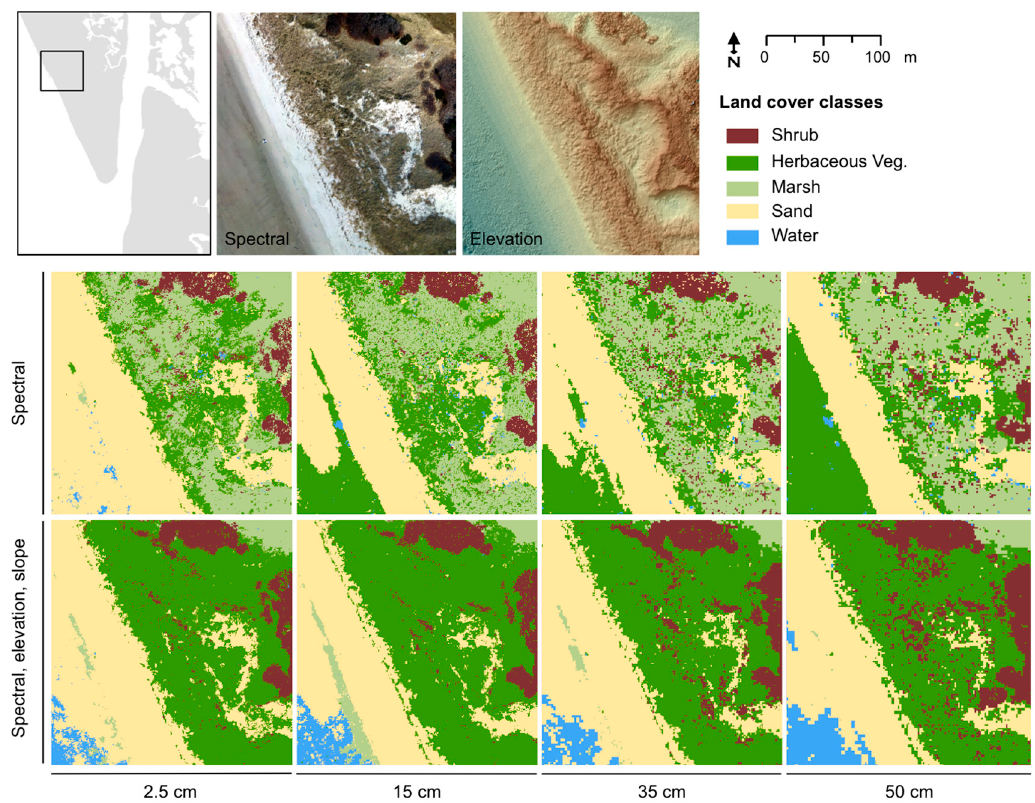
Figure 8. Example area of land cover maps of Black Beach classified from RGB with and without topographic data at four resolutions.